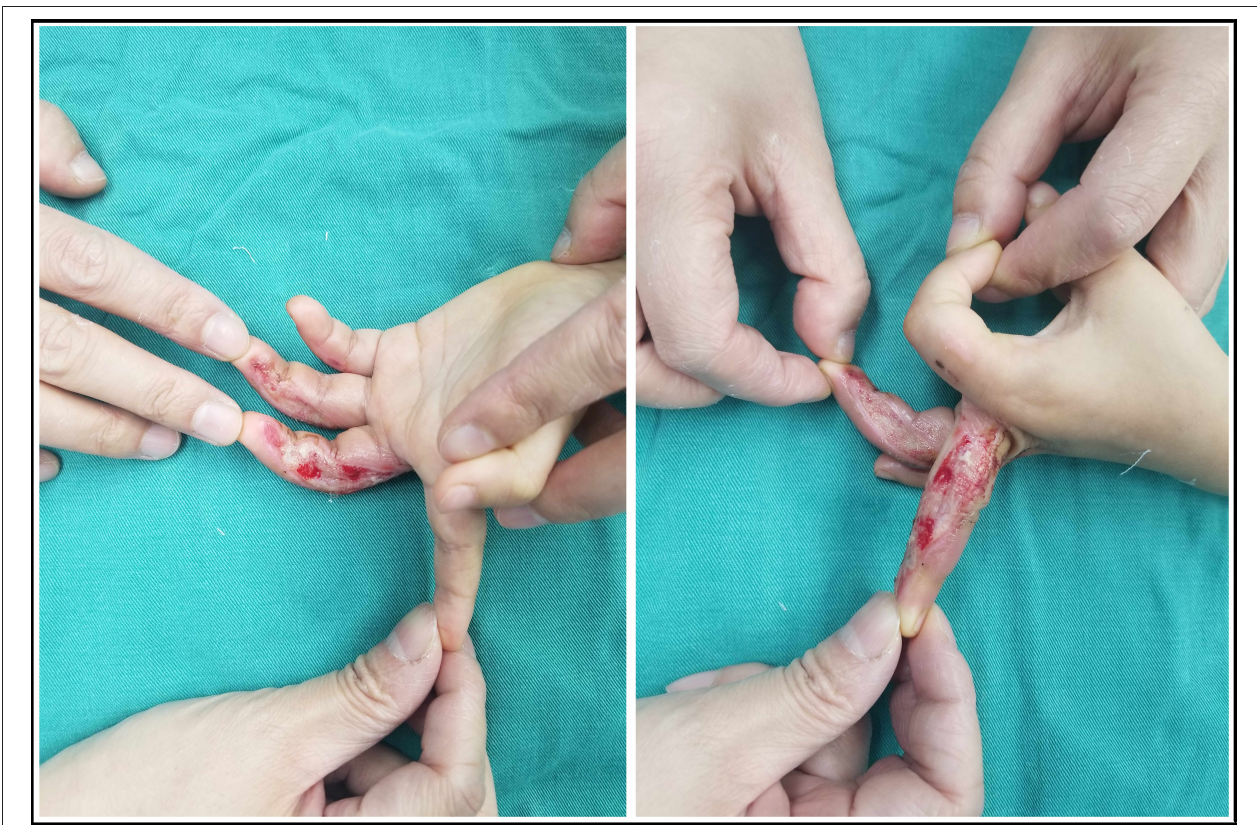
FIGURE 2 | Treadmill hand injury in the index finger, middle finger, and ring finger of the right hand. The patient initially received 9 days of outpatient dressing changes in our center. The wound in index finger and small finger were almost healed. However, the wound in middle finger and ring finger were serious, presenting a poor